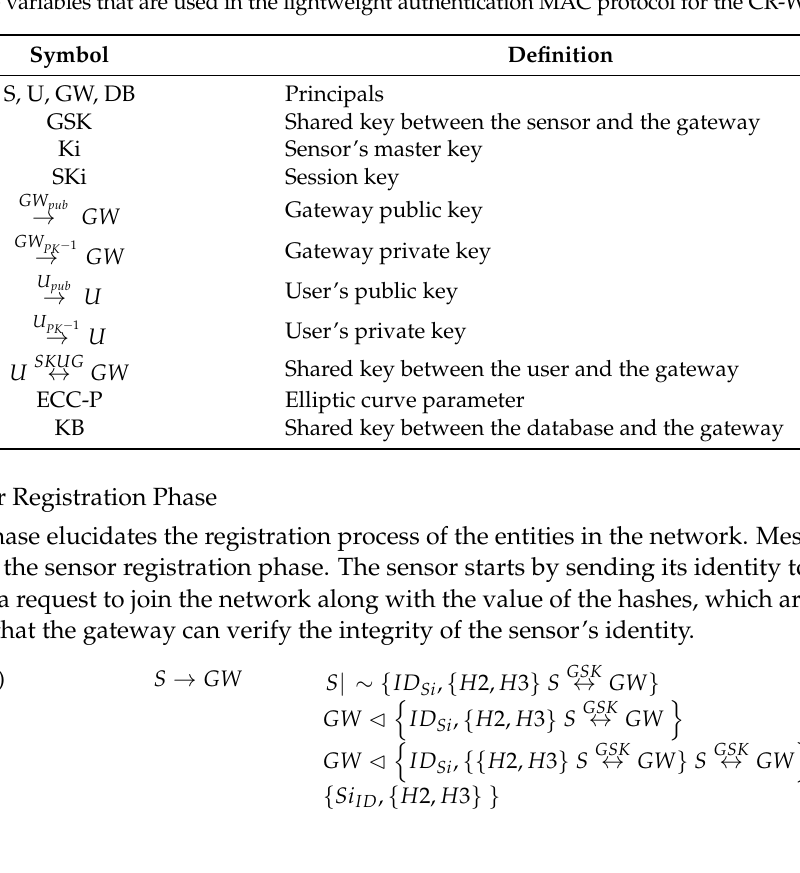
Table 10. The variables that are used in the lightweight authentication MAC protocol for the